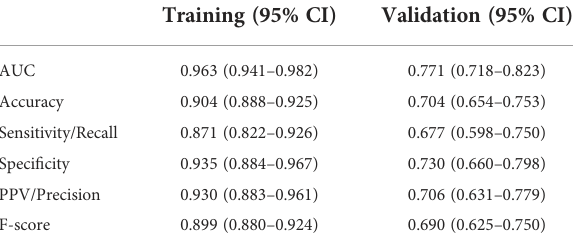
TABLE 3 Model performance of diagnostic accuracy in the derivation and validation